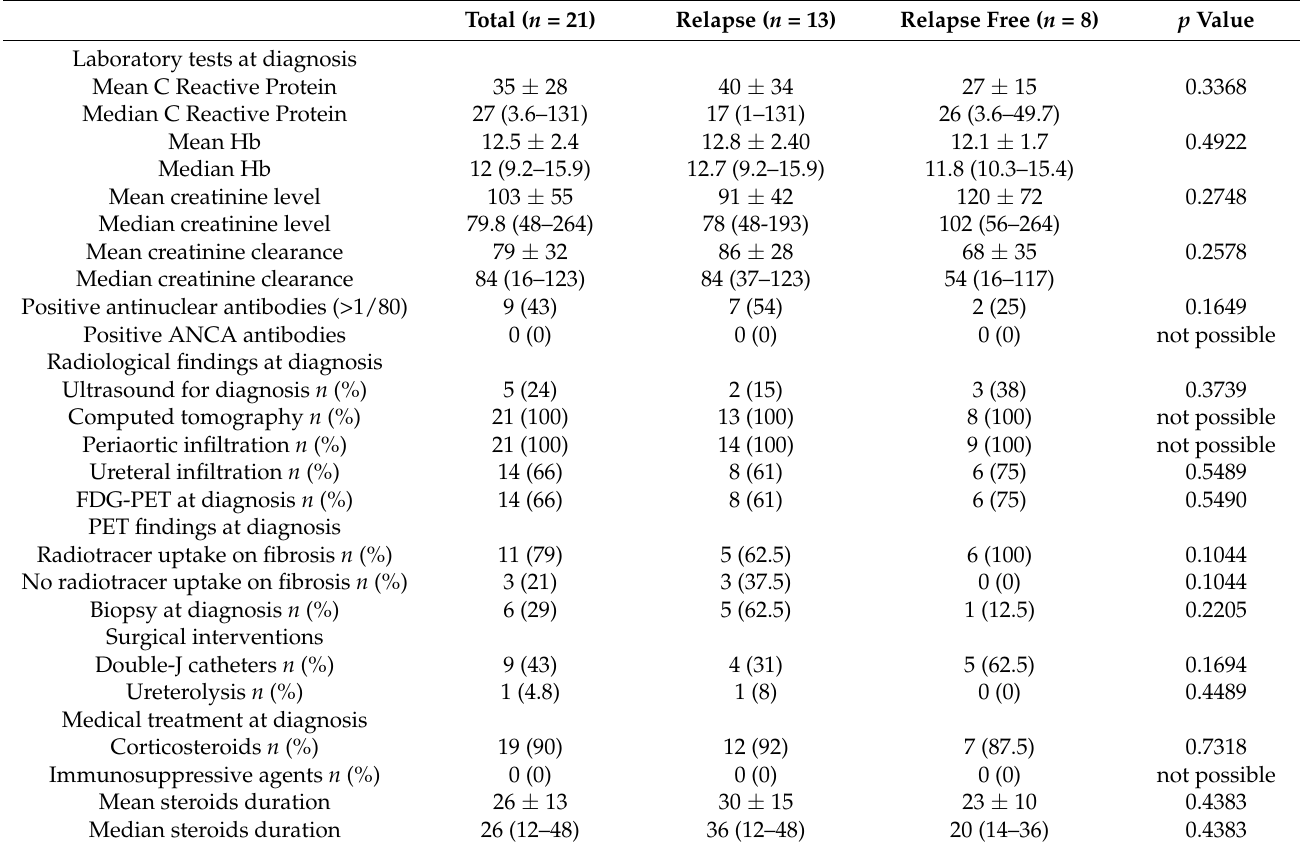
Table 2. Laboratory examination, radiological features and treatments at